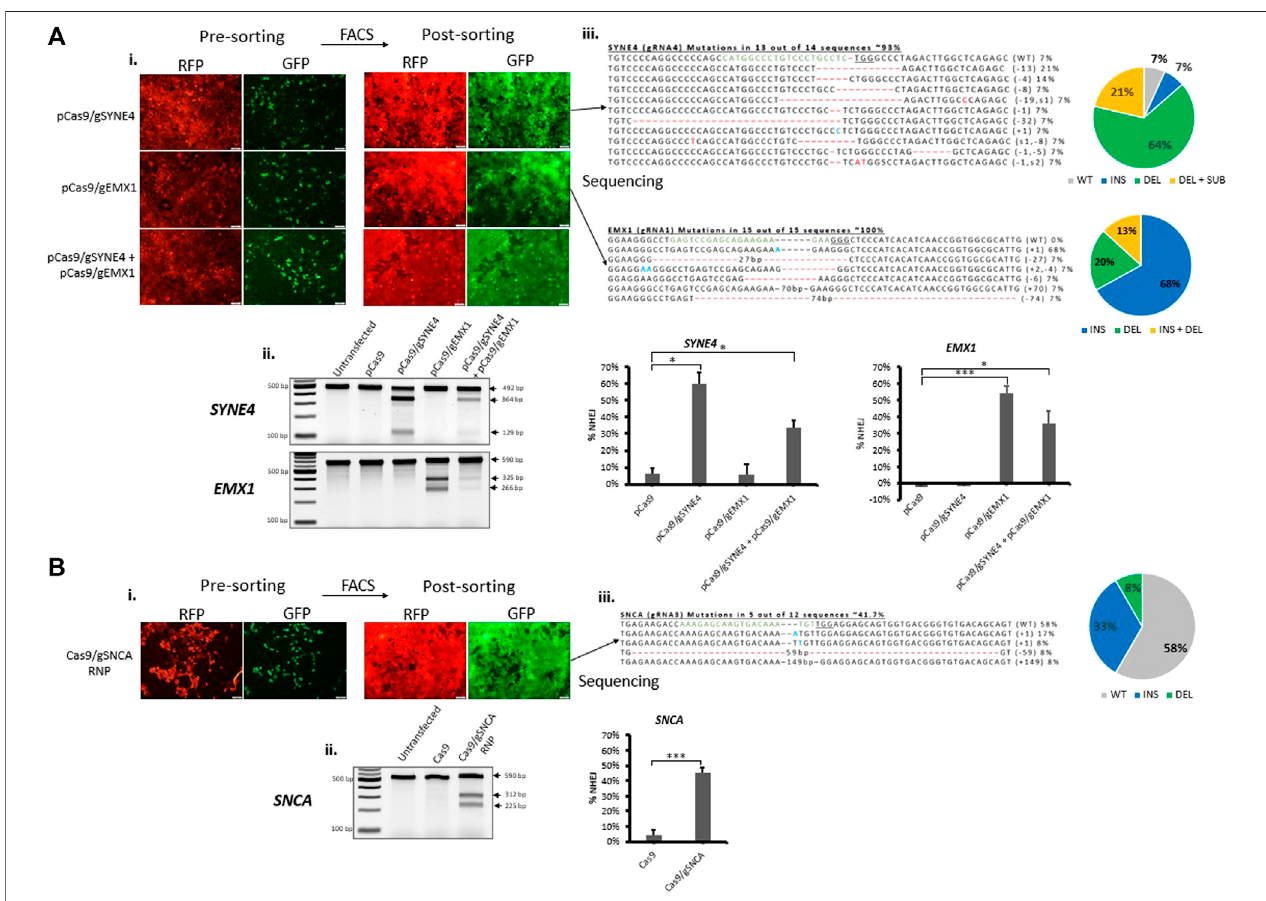
FIGURE 4 | Fluorescence-assisted enrichment of HEK293 cells containing CRISPR-induced mutations. Fluorescent reporter HEK293 cells were transfected with plasmid (A) or Ribonucleoprotein (RNP) (B) targeting endogenous genes. (Ai,Bi) Microscopy images of pre- and post-sorted cells. (Aii,Bii) T7 Endonuclease I assay carried outon genomic DNAextracted from post-sorted cellsshowing indelshavebeen formed incellstreated eitherwithplasmid orRNPtargeting endogenousgenes. Quanti fi cation of indels in T7E1 is shown on the right. Values were background corrected from Untransfected group. Results are expressed as mean ± standard errorofthemeanof n =3fromT7E1assaycarriedoutongenomicDNAoftargetedcells.Therewasasigni fi cantdifferenceinfrequencyofindels(*, p < 0.05;**, p < 0.01; ***, p < 0.001) between groups treated with Cas9 alone or Cas9 and gRNA targeting an endogenous gene, as analysed by Student ’ s t -test. (Aiii,Biii) Sanger ’ s sequencing of clones revealing CRISPR-induced indels and mutations. gRNA binding site (green) in the wildtype (WT) sequence is shown, the PAM sequence is underlined, dashes indicate deletions ( − ), nucleotides colored in blue indicate additions (+), and nucleotide colored in red indicate substitutions (s). Mutation frequencies are calculated as the number of clones carrying a mutation divided by the total number of clones